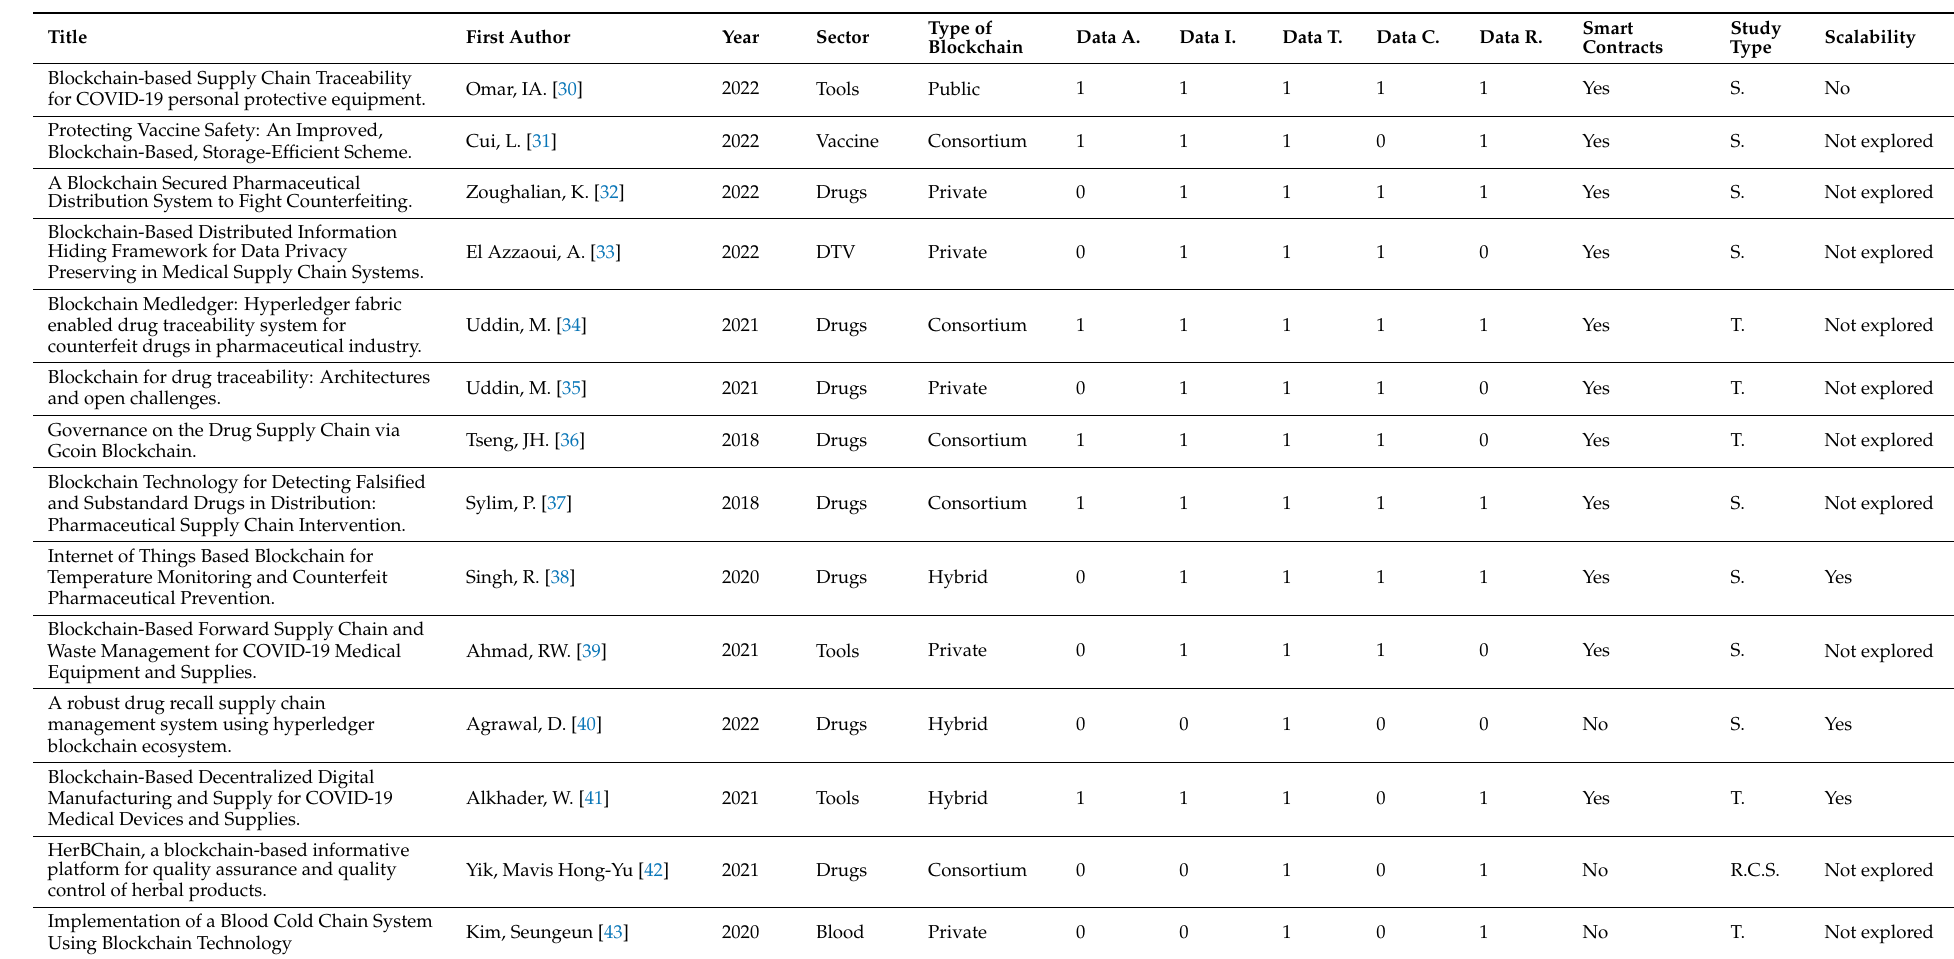
Table 1. Summary of the included